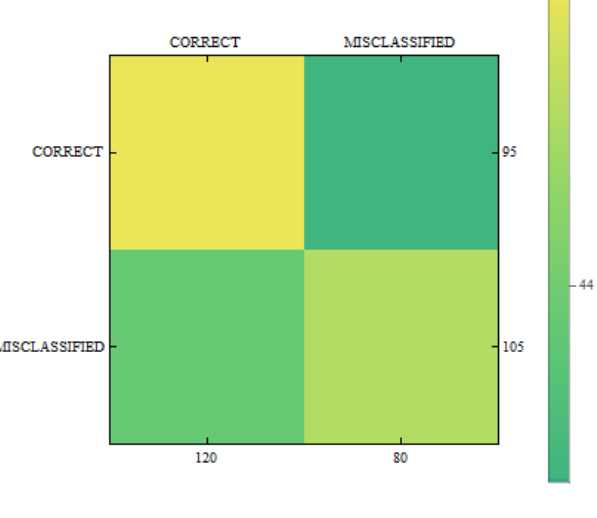
Figure 11. Confusion matrix for measurements obtained by the classifier using PH2 Dataset